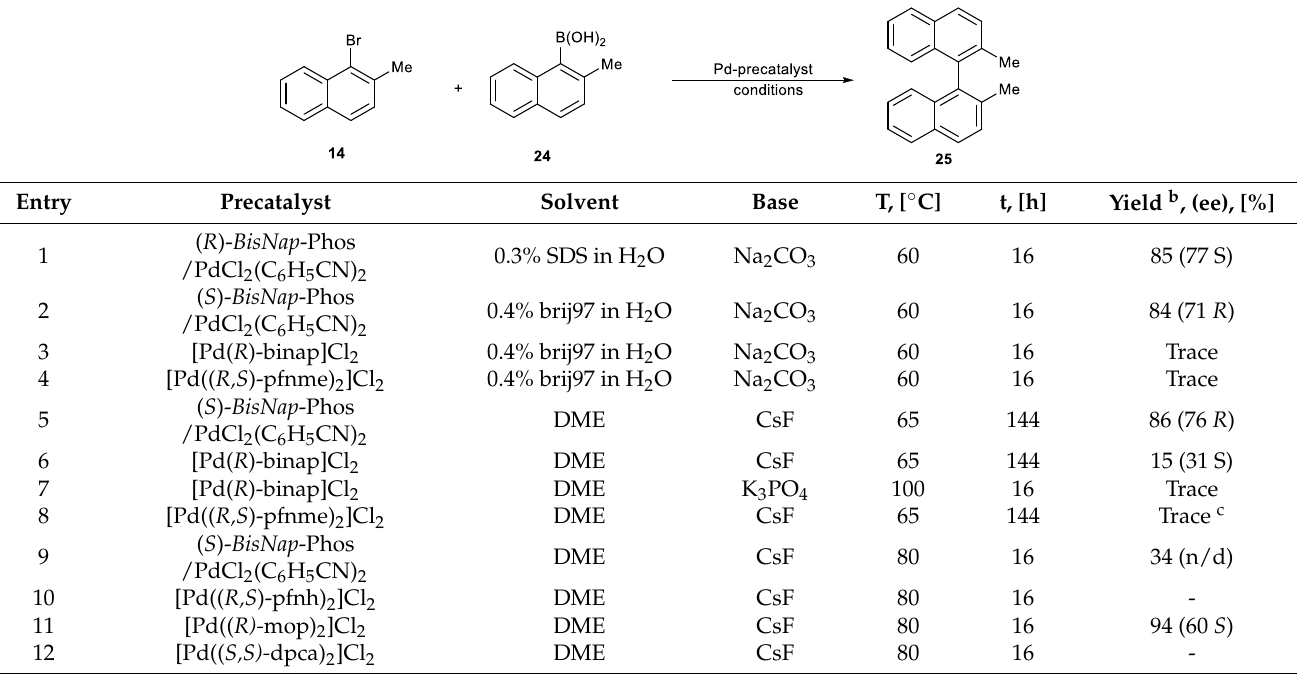
Table 9. Ligand activity in asymmetric synthesis of 2, 2′ -dimethyl-1, 1′ -binaphthyl ( 25 ) a